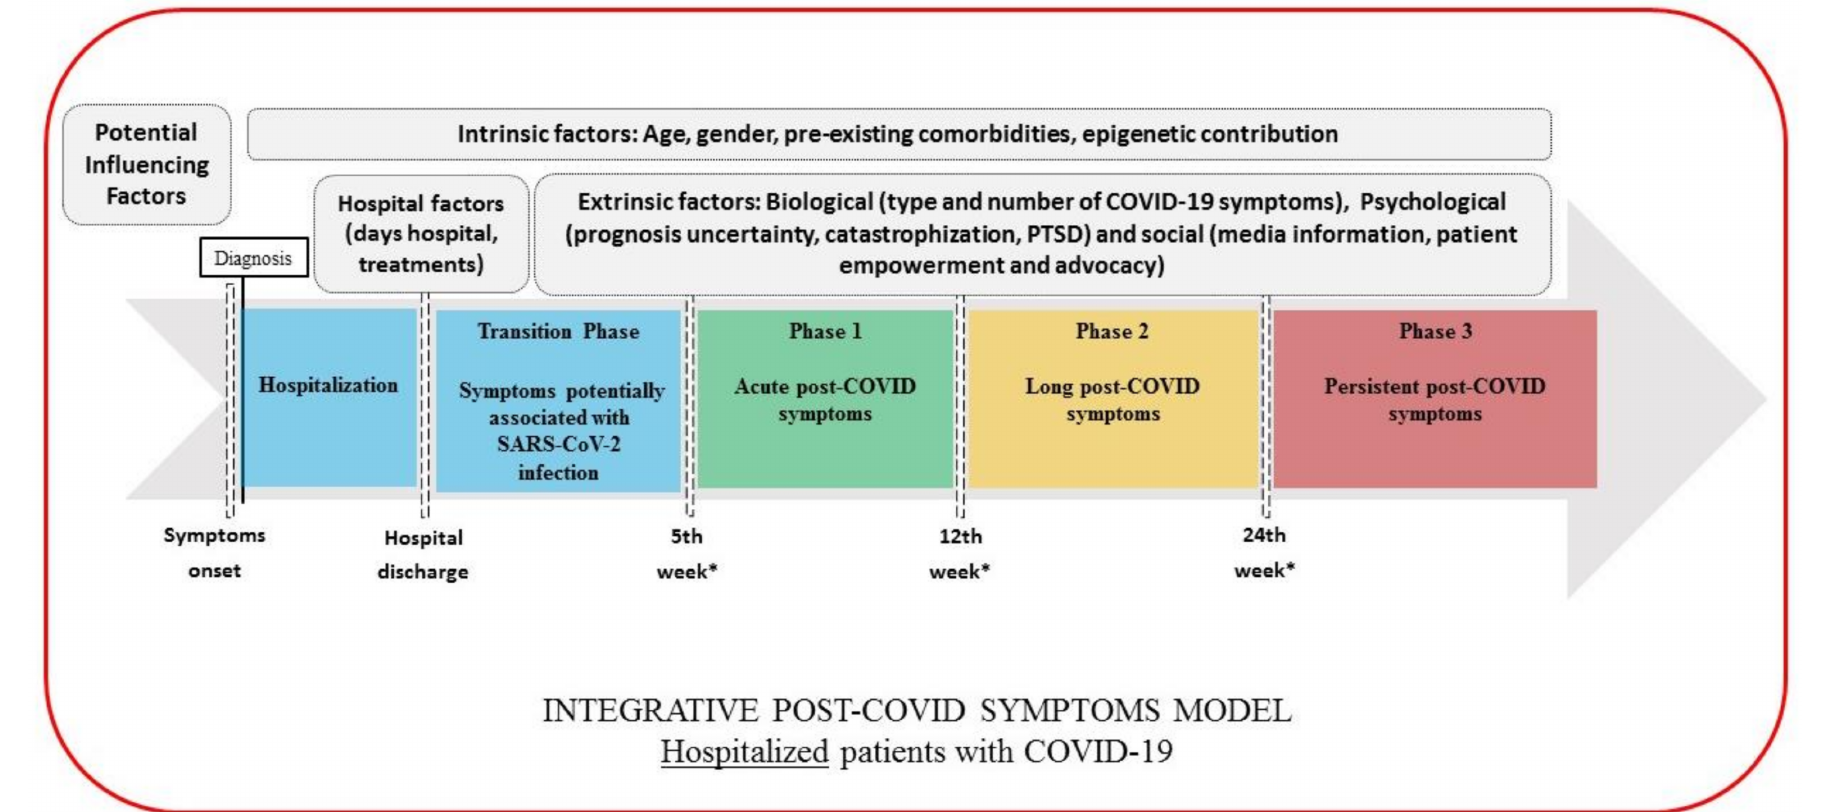
Figure 2. Integrative post-COVID symptoms model in hospitalized patients showing transition phase (blue), and phases 1 (green), 2 (yellow), and 3 (red) of post-COVID symptoms. PTSD: post-traumatic stress